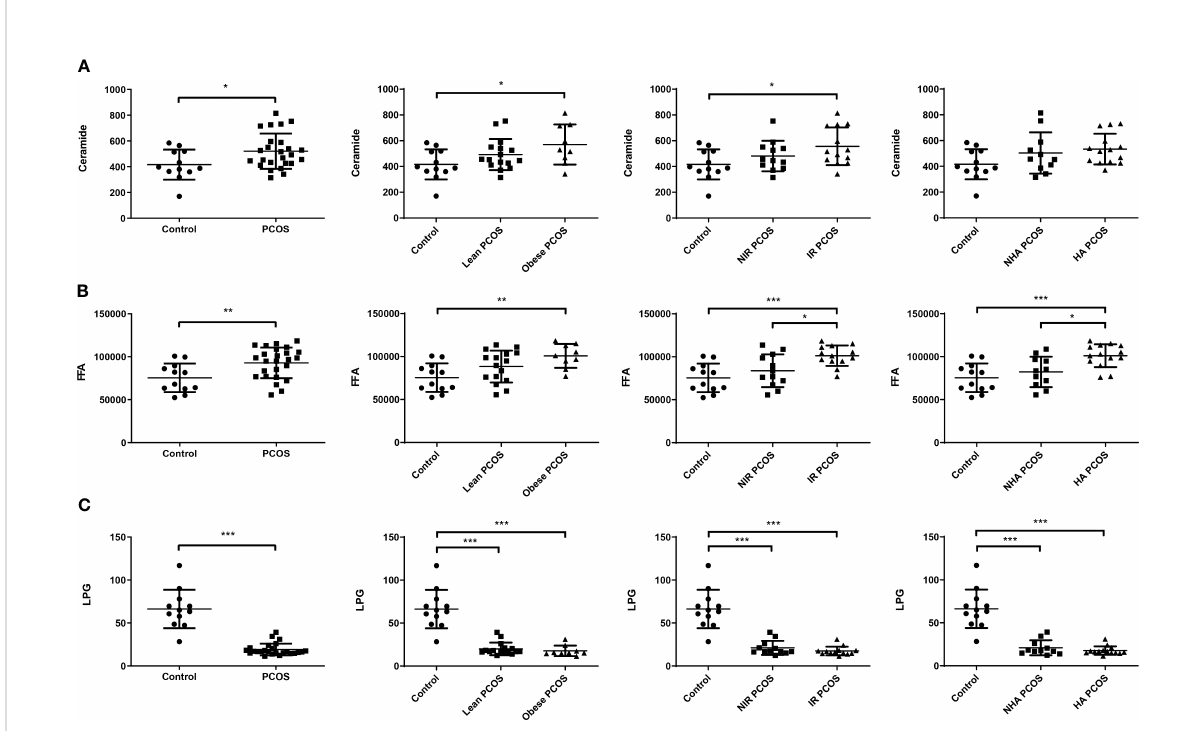
FIGURE 1 Changes in FF lipids in patients with PCOS ( n = 25) and healthy controls ( n = 12). FF ceramide (A) , FFA (B) , and LPG (C) levels in PCOS patients with different phenotypes and controls. Data are expressed as mean ± SD. * P < 0.05, ** P < 0.01, *** P < 0.001.